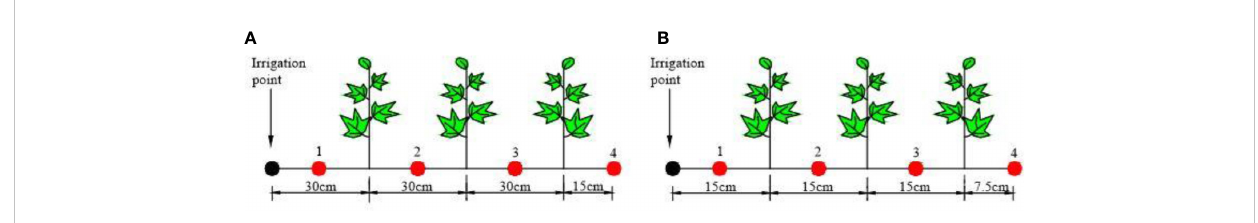
FIGURE 1 Cotton planting spacing and sampling point setting. (A) 30-cm planting spacing. (B) 15-cm planting